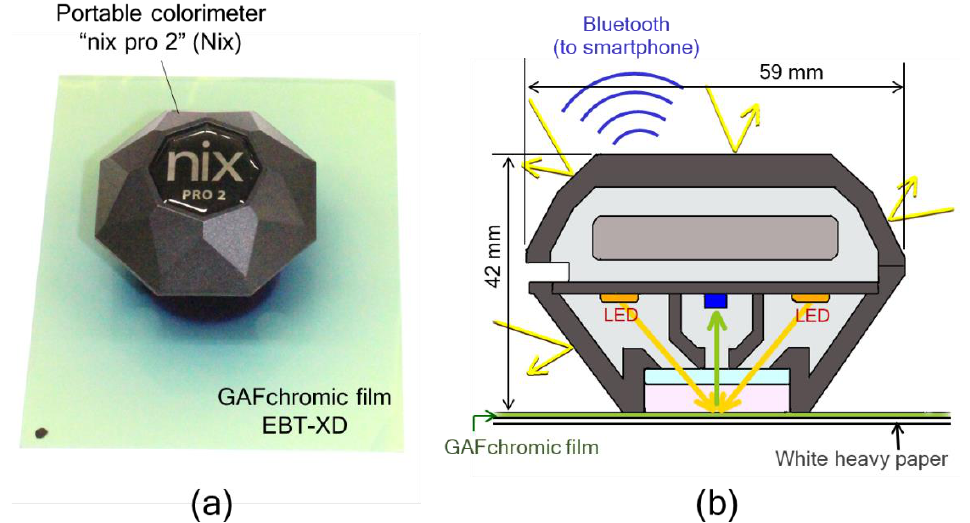
Figure 1. The materials used for this study ( a ): Gafchromic film “EBT-XD” and a portable colorimeter “nix pro 2” (abbreviated to “Nix” here) and a cross-section drawing of Nix ( b ). The black frame structure of Nix blocks well the ambient light; two LED sources (orange part) cast light beams and a color sensor (blue part) detects the reflected light; the data of color intensities measured as RBE and CMYK components are transferred to a smartphone via Bluetooth.